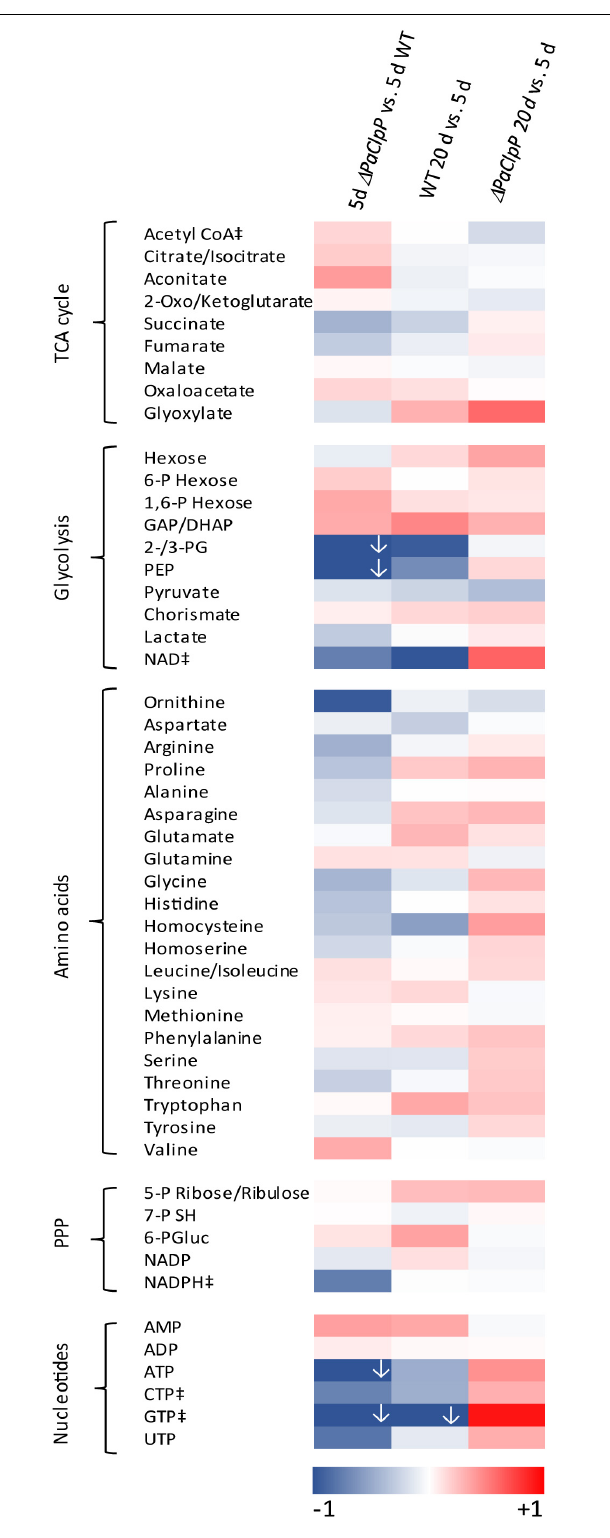
FIGURE 1 | Deletion of PaClpP affects the energy metabolism. Color-coded heat map shows the fold change log(2) of 5-day-old (cid:49) PaClpP vs.